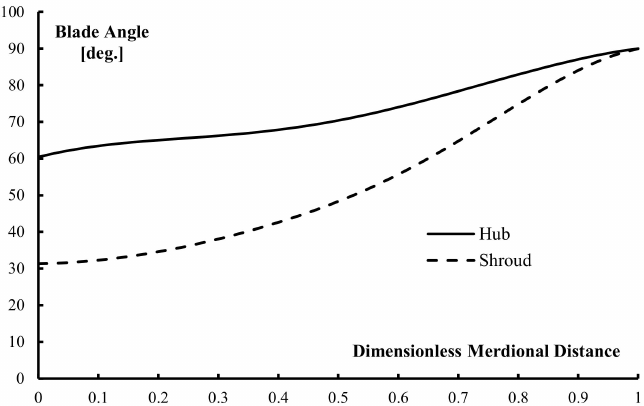
Figure 8. Rotor blade angle in the hub and shroud